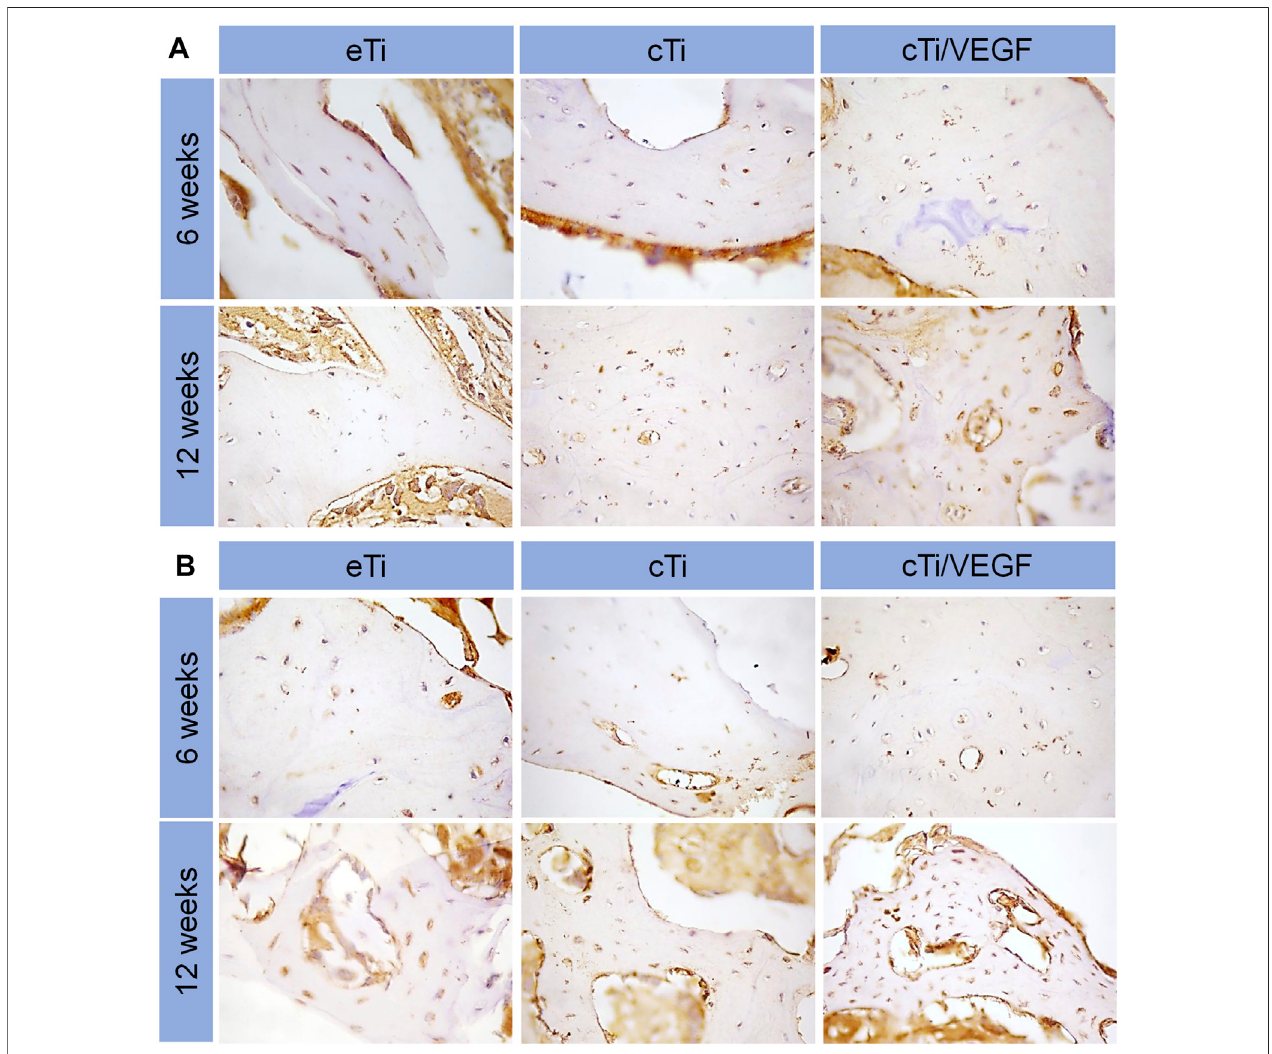
FIGURE7| Immuno fl uorescencestainingofCOLI (A) andCD31 (B) expressioninbonesurroundingscaffoldsofeTi,cTi,andcTi/VEGFafterimplantationfor6and 12 weeks (n (cid:1) 3).